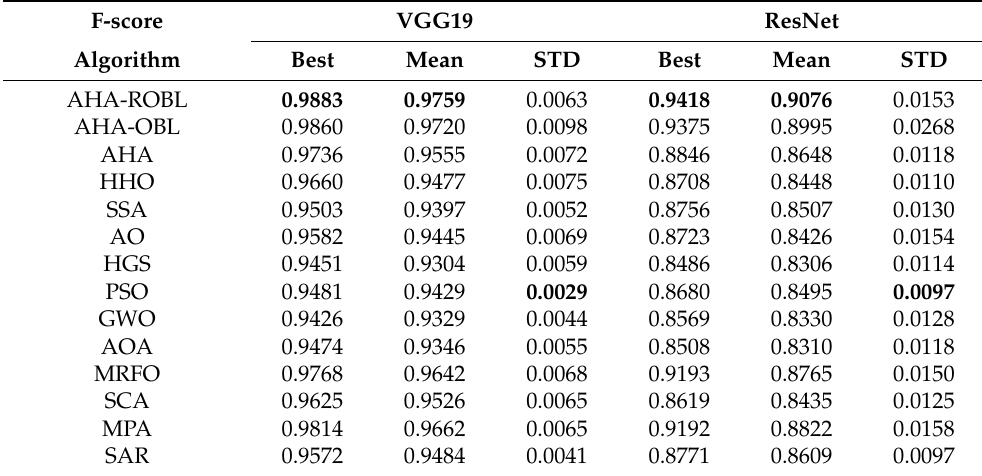
Table 8. Comparison of the performance of deep features models of the AHA-ROBL with other recent optimizers versus